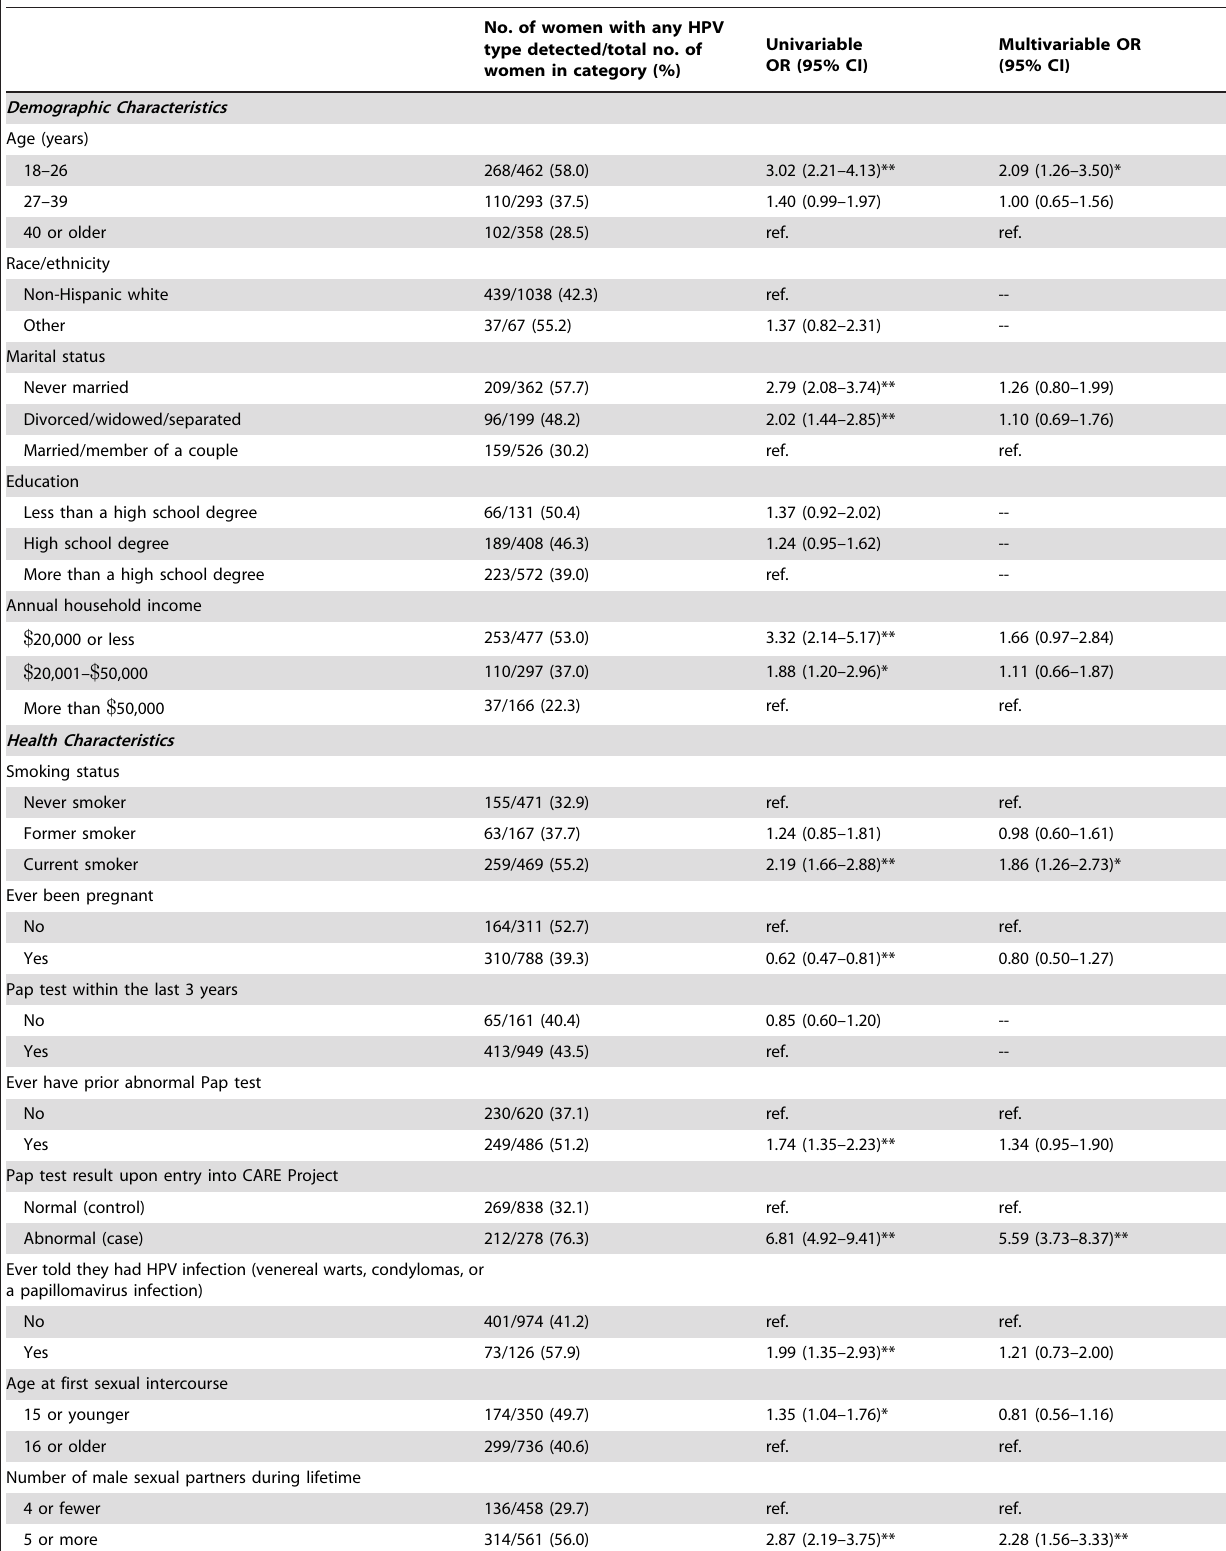
Table 4. Detection of any HPV type among women from the CARE Project (n=1116).